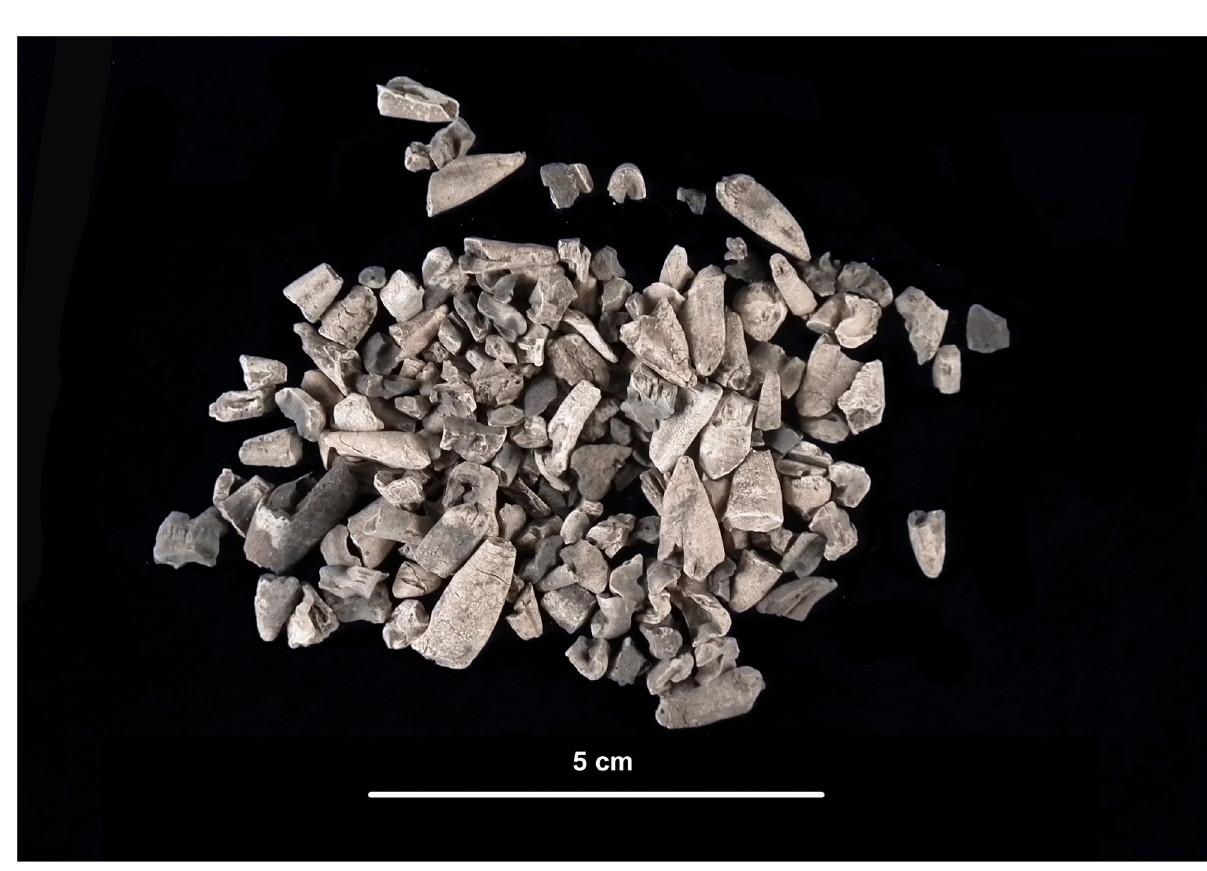
Fig 5. Example of tooth fragments from feature “US